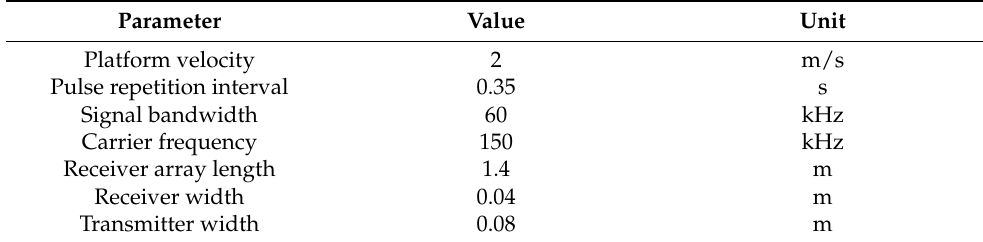
Figure 3. Signal model error for the last transmitter/receiver pair when the system works with narrow-bandwidth. ( a ) r = 40 m; ( b ) r = 110 m; ( c ) r = 180 m; ( d ) r = 250 m. The SAS parameters are listed in Table 2 when the SAS works with a wide-bandwidth signal. Table 2. SAS parameters with wide bandwidth.